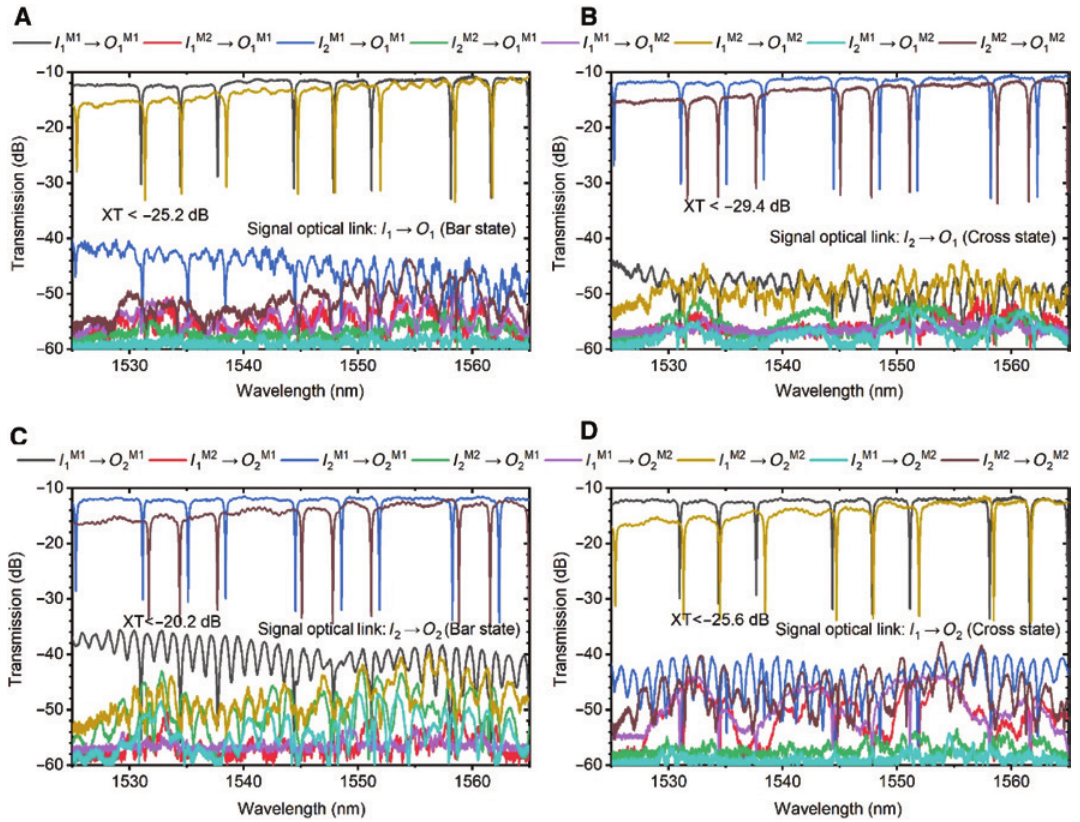
→ O → O → O → O (A), I (B), I (C), I (D) and the corresponding noise links. 1 1 2 1 2 2 1 2